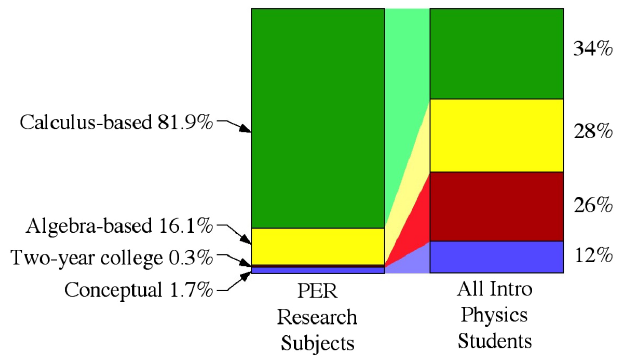
FIG. 2. Comparison of distribution of research subjects in